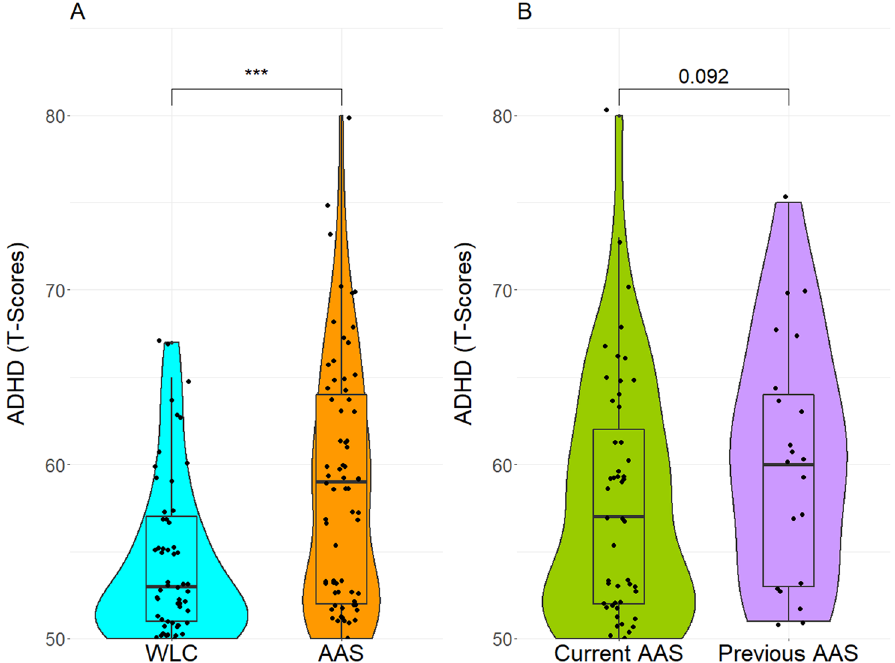
Figure 1. ADHD symptoms among AAS users and WLC. AAS-using male weightlifters (n = 72) and WLC (n = 62) complete the ASEBA questionnaire on ADHD symptoms. ( A ) Shows ADHD symtoms presented as T scores in AAS users and controls. ( B ) Shows ADHD symptoms presented as T scores in current and previous users of AAS. ADHD: attention deficit/hyperactivity disorder, WLC: weightlifting controls, AAS: anabolic androgenic steroids.